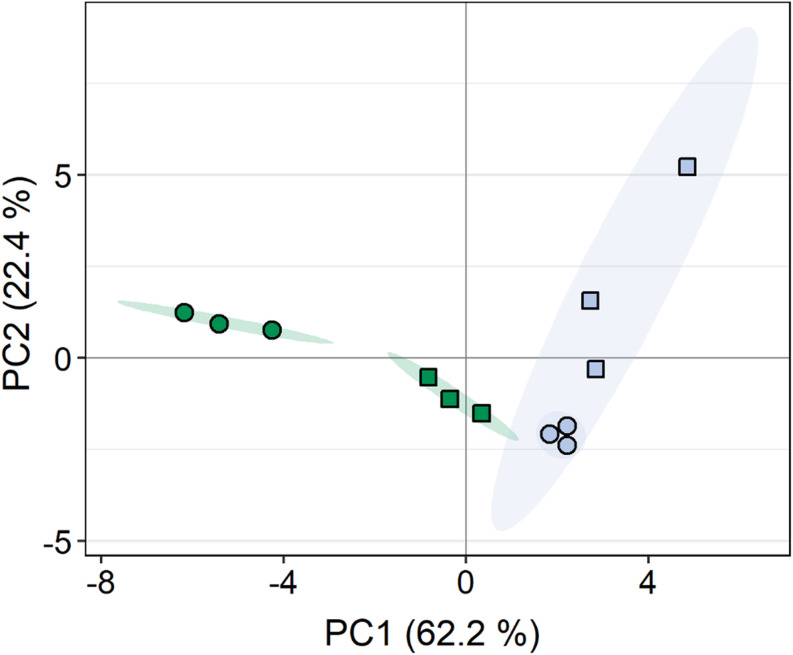
Principal component analysis of metabolite profiles in response to dehydration and rehydration of two Chlorella vulgaris strains. Blue symbols denote the aquatic strain and green symbols show the terrestrial strain. Circles show algae before dehydration (controls) and rectangles show algae after the end of rehydration (n = 3).